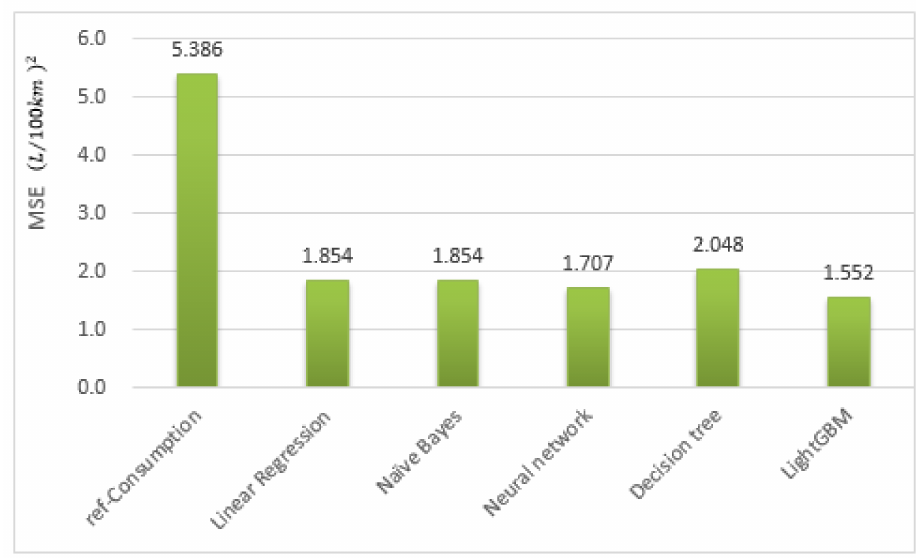
Figure 4. MSE of different